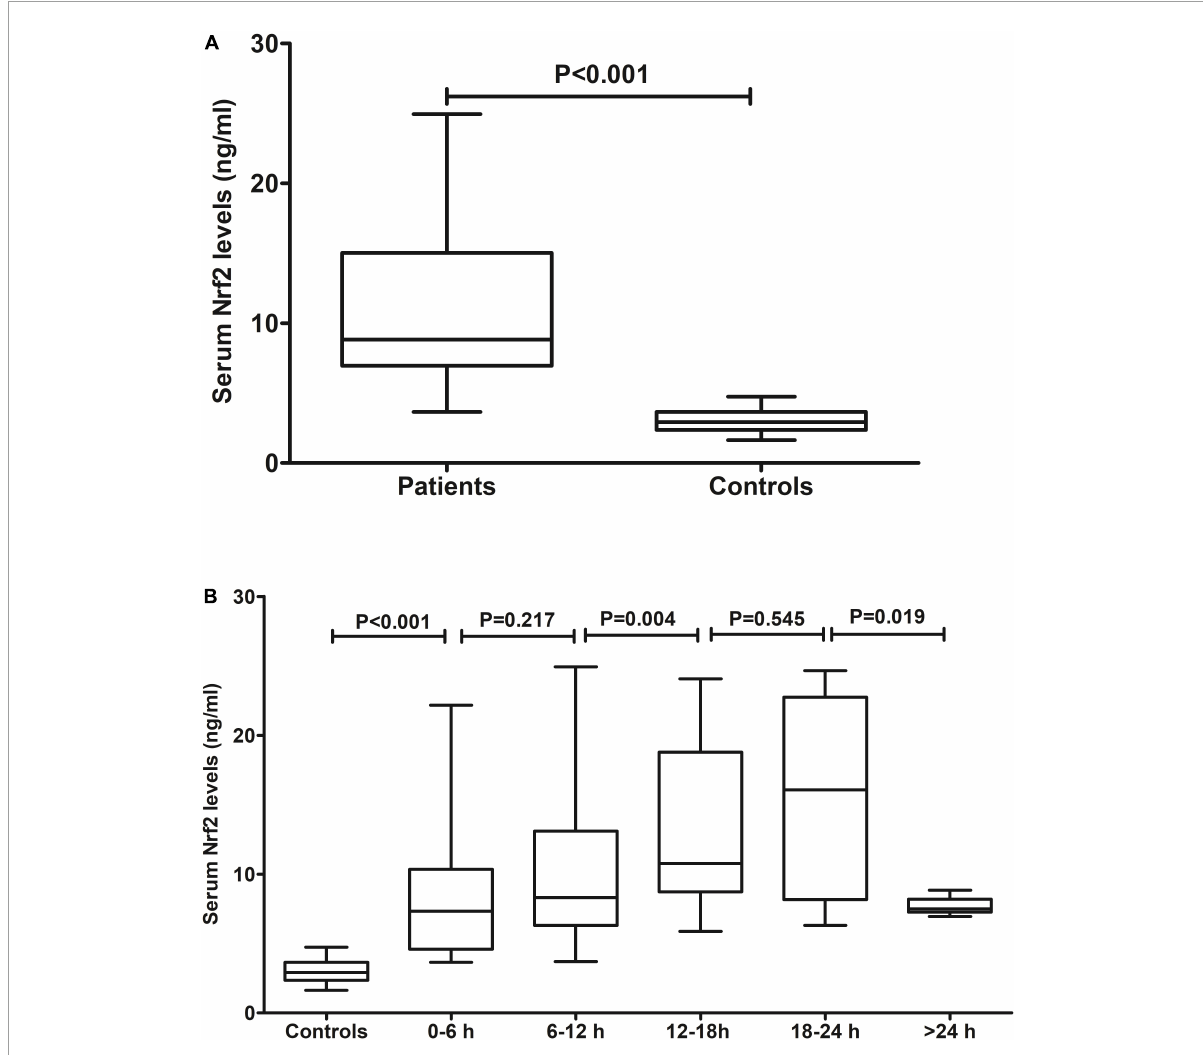
FIGURE2 Serum nuclear factor erythroid 2-related factor 2 (Nrf2) levels after acute intracerebral hemorrhage (ICH). (A) Difference in serum Nrf2 levels between controls and patients. (B) Dynamic change in serum Nrf2 levels after acute ICH. After stroke, serum Nrf2 levels of patients increased during the 6-h period immediately, peaked at 12–18 h, plateaued at 18–24 h, decreased gradually thereafter, and were significantly higher than those in healthy controls (all P < 0.05). Nrf2 indicates nuclear factor erythroid 2-related factor